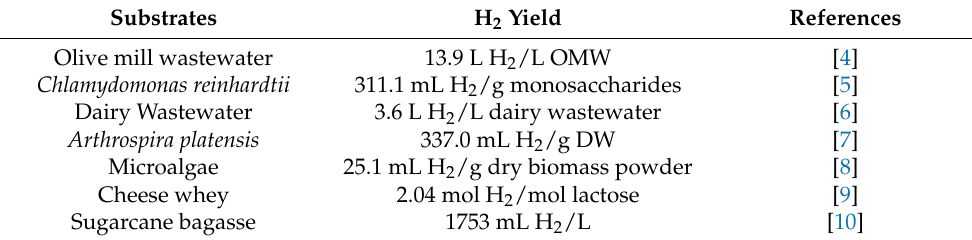
Table 1. Biohydrogen production using various